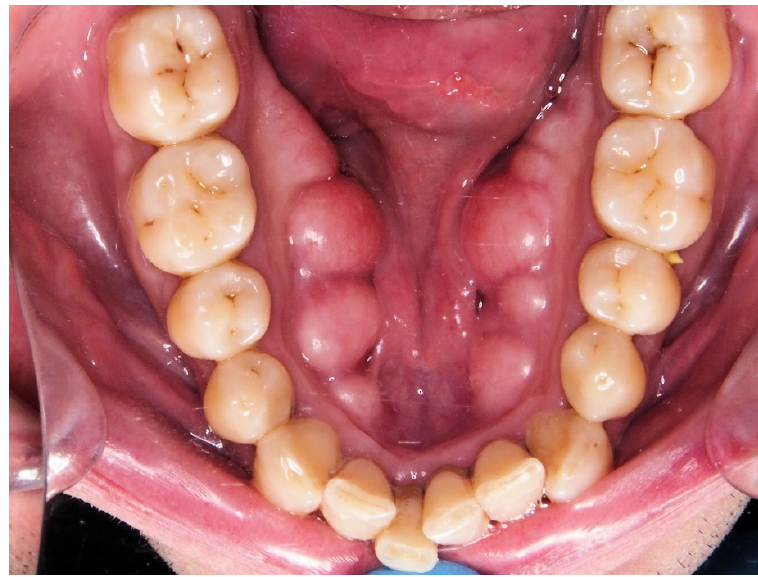
Figure 2. Mandibular torus.